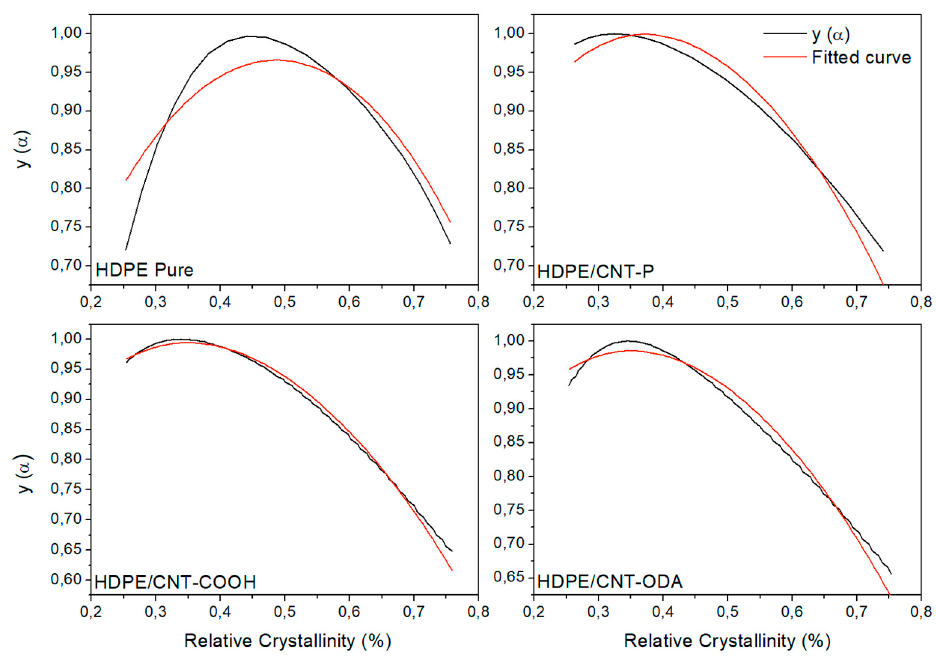
Figure 7. Curves of y ( α ) versus α normalized and fitted by Equation (27) for pure HDPE and HDPE/CNT nanocomposites. Table 3. Avrami coefficient “ n ” of the empirical kinetic JMA model for pure HDPE and HDPE/CNT nanocomposites.